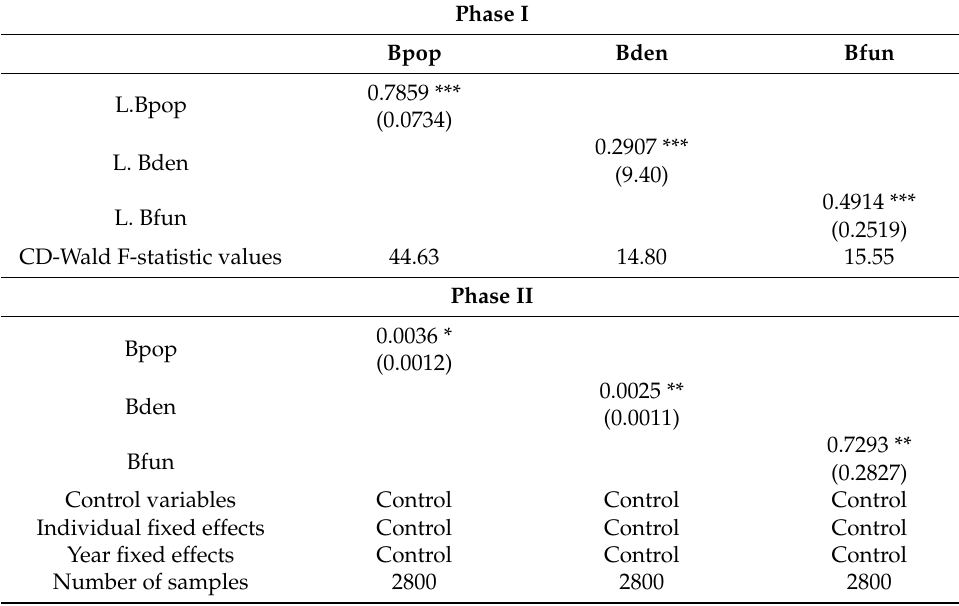
Table 8. Estimation results of double-threshold